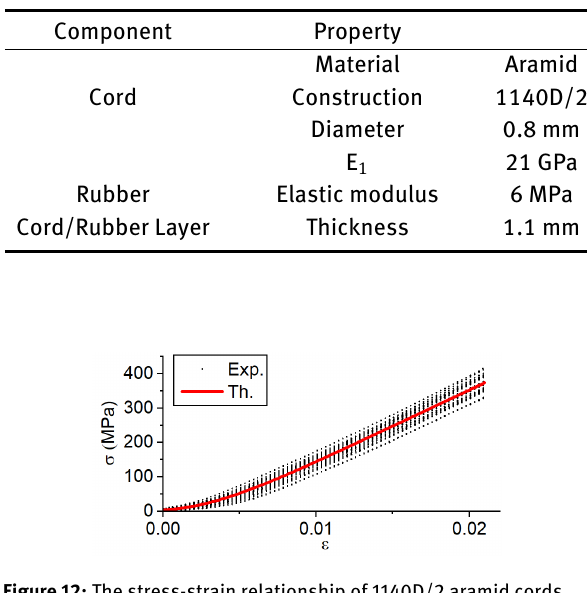
Figure 12: The stress-strain relationship of 1140D/2 aramid cords.